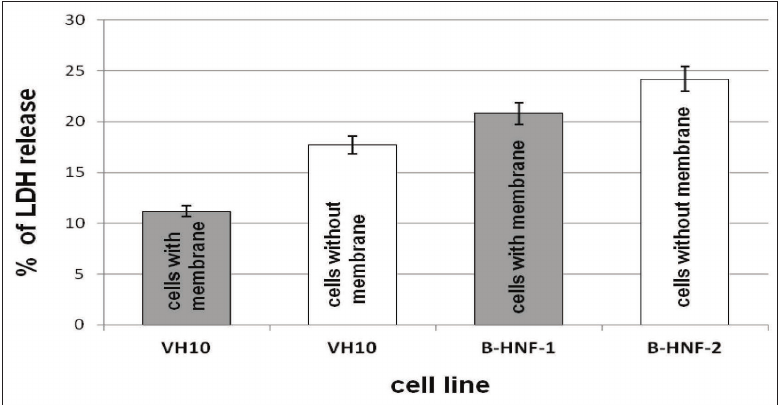
Fig. 4. Detection of apoptotic DNA fragmentation in human fibroblast cells treated with coladerm-beta glucan membrane for 4 days. a - VH10 cells without membrane (negative control); b - VH10 cells with membrane (b); c - positive control (the cells treated with 6 μM cisplatin for 24 h); d - B-HNF-1 cells without membrane (negative control); e - B-HNF-1 cells with membrane.